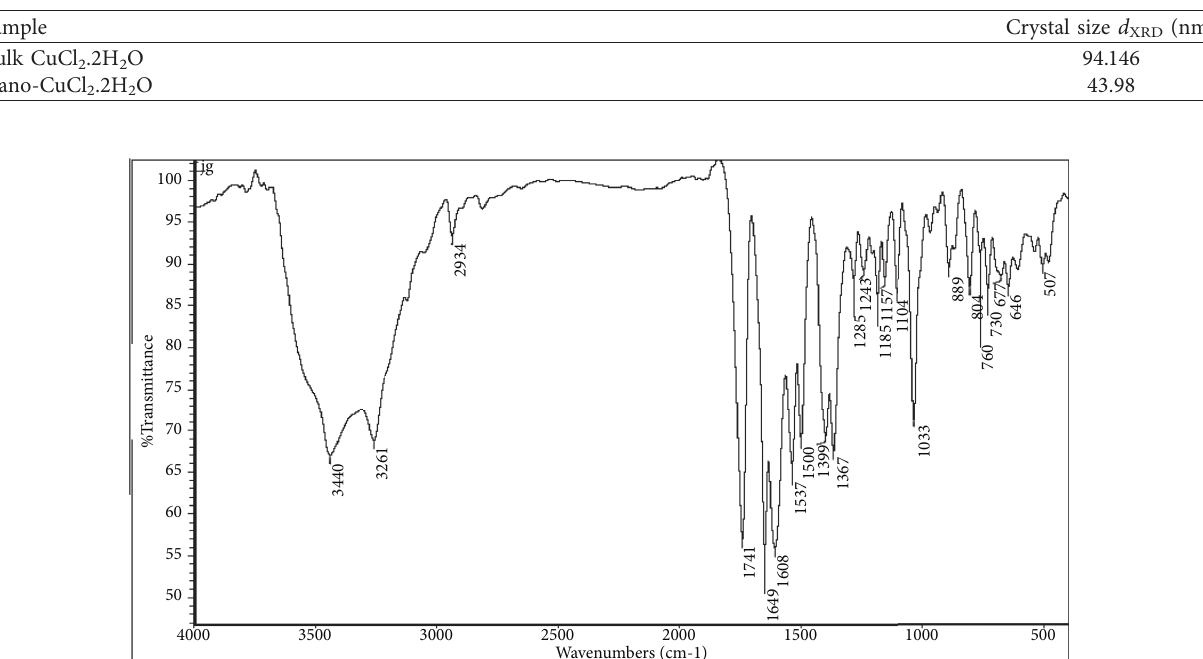
Figure 3: IR spectra of ceftriaxone